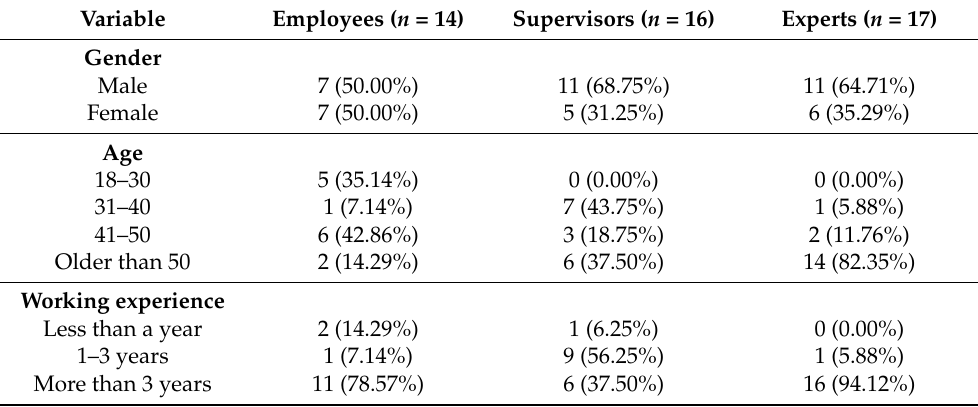
Table 4. Participant characteristics ( n =